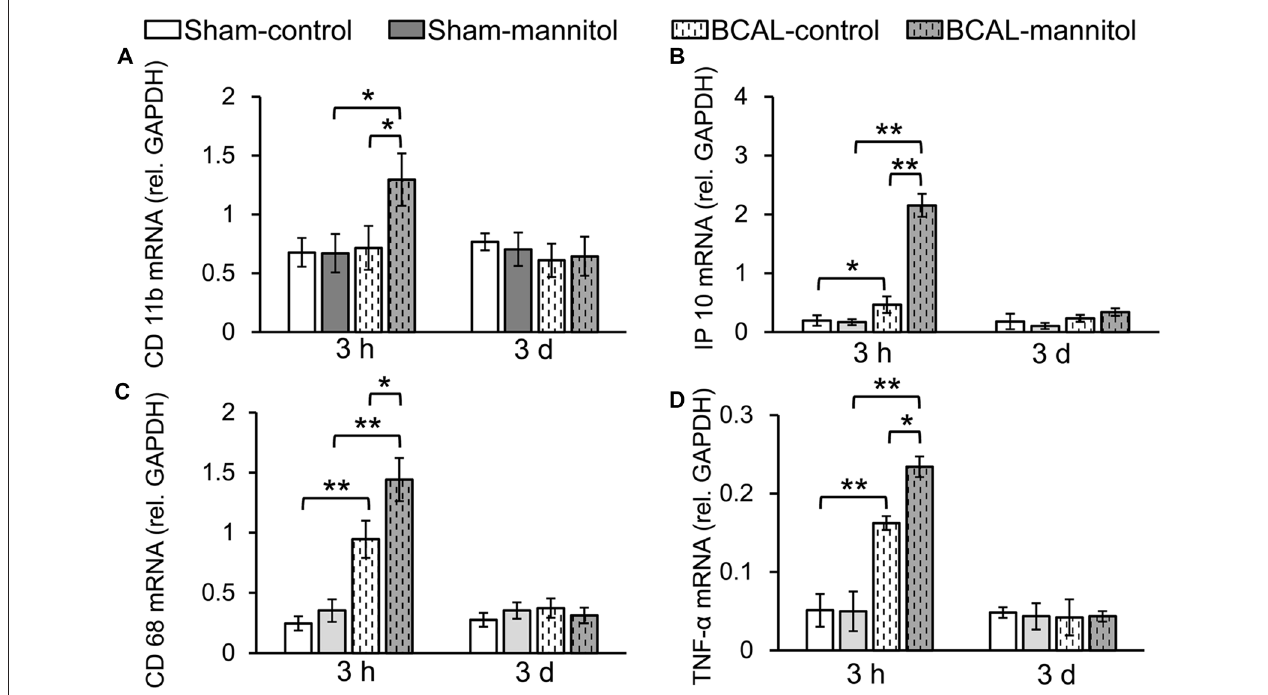
FIGURE 3 | Mannitol-induced change in the mRNA expression level of inflammatory cytokine following reperfusion after ischemia. (A–D) There was no significant difference in mRNA expression levels of integrin alpha M (CD11b), CD68 , tumor necrosis factor alpha (TNF- α ) and chemokine (C-X-C motif) ligand 10 (IP10) at 3 h between sham-control mice and sham-mannitol mice. Ischemia-induced significant increase in CD68, TNF- α and IP10 , but not CD11b at 3 h. However, the mRNA expression levels of CD11b, CD68, TNF- α and IP10 are all significantly increased in BCAL-mannitol mice compared with BCAL-control mice or sham-mannitol mice at 3 h. There are no significant differences in the mRNA expression levels of CD11b, CD68 , TNF- α and IP10 at 3 days. n = 6 mice for each group. ∗ p < 0.05 and ∗∗ p <